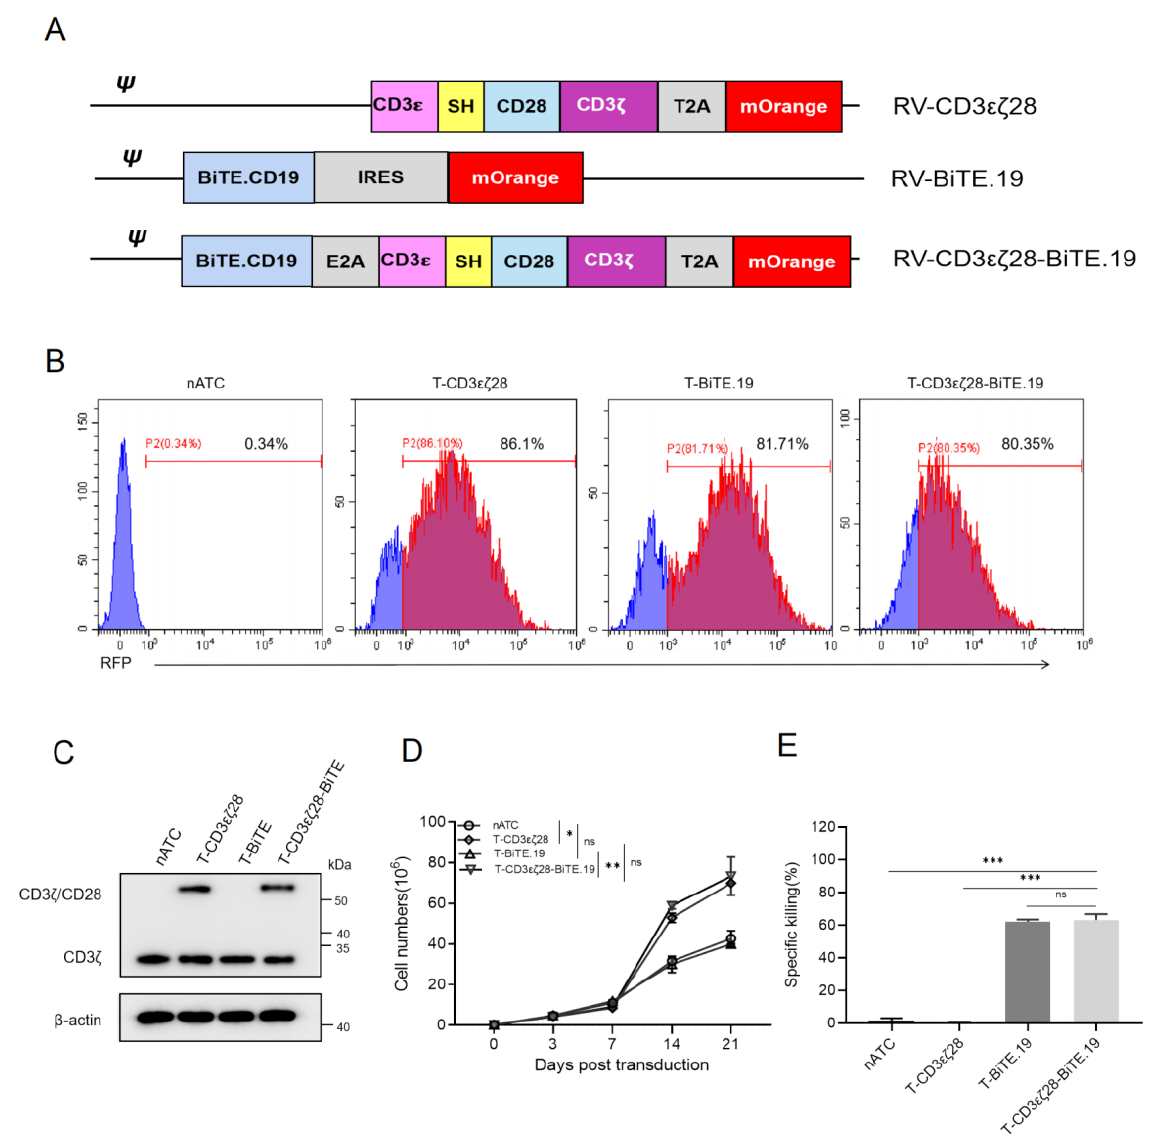
Figure 4. Generation of T-CD3 εζ 28-BiTE.19 cells. ( A ) Schematic diagram representing different engineering T cells. ( B ) Flow cytometry analysis showed the transduced rate of retrovirus carrying CD3 εζ 28-mO or BiTE-mO or CD3 εζ 28-BiTE-mO in T cells. nATC was a non-transduced control. ( C ) The expression levels of endogenous CD3ζ and CD3εζ28 fusion prote in in different T cells were evaluated by western blotting with anti- CD3ζmAb. ( D ) The growth curves of different T cells were made based on the cell number counting at indicated timepoint for 21 days in vitro. ( E ) Histograms display the percentages of specific cancer cell killings of nATC cells mediated by BiTE targeting CD19. The supernatant from cultured nATC, T- CD3εζ28, T -BiTE.19 and T- CD3εζ28 -BiTE.19. cells were collected. Then the nATC cells were co-cultured with Hela cells expressing CD19 (Hela-CD19) in a 2:1 ratio supplemented with the collected cell supernatant for 24 h. The viability of co-cultured Hela-CD19 cells was determined by MTS assay. Statistical differences were assessed by mutual com- parison between each two groups using multiple comparisons t test. (* p < 0.05, ** p < 0.01, *** p < 0.001). 3.5. T- CD3εζ28 -BiTE.19 cells Exhibited Superior Killing Effects on Cancer Cells To further determine the killing effects of T- CD3εζ28 -BiTE.19 on cancer cells, Nalm6, Raji, Daudi and K562-CD19 (Figure S3A) were co-cultured with different types of T cells at indicated E:T ratios. The results showed that T- CD3εζ28 -BiTE.19 and T-BiTE.19 cells could specifically kill cancer cells, whereas nATC and T- CD3εζ28 cells had almost no kill- ing effects due to lacking CD19-BiTE, and that T- CD3εζ28 -BiTE.19 had a stronger cyto- toxicity than T-BiTE.19 cells (Figure 5A). To investigate if T- CD3εζ28 -BiTE.19 cells are highly activated when co-cultured with cancer cells, the concentrations of IFN- γ and IL -2 in cell culture supernatants were determined by ELISA in Nalm-6 cell group. The results showed that the T- CD3εζ28 -BiTE.19 cells secreted highest levels of IFN- γ and IL -2 among